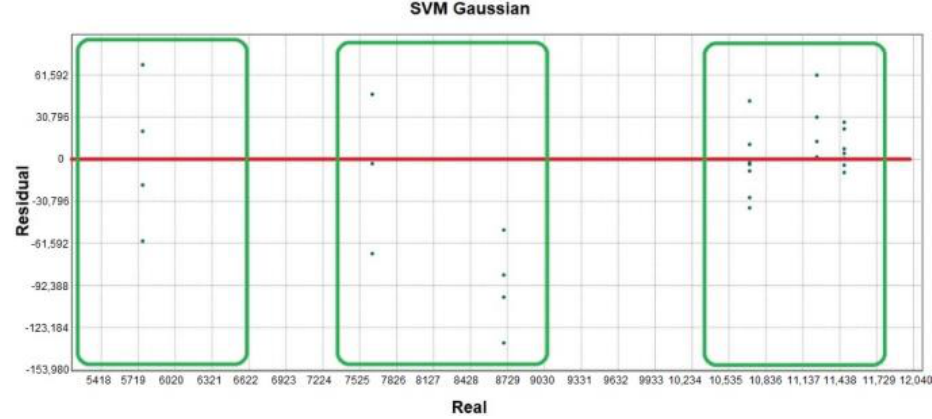
Figure 11 . Distribution of the residuals using the SVM with Gaussian kernel algorithm. Figure 11. Distribution of the residuals using the SVM with Gaussian kernel algorithm. Table 5. Early prediction of crop data for each year